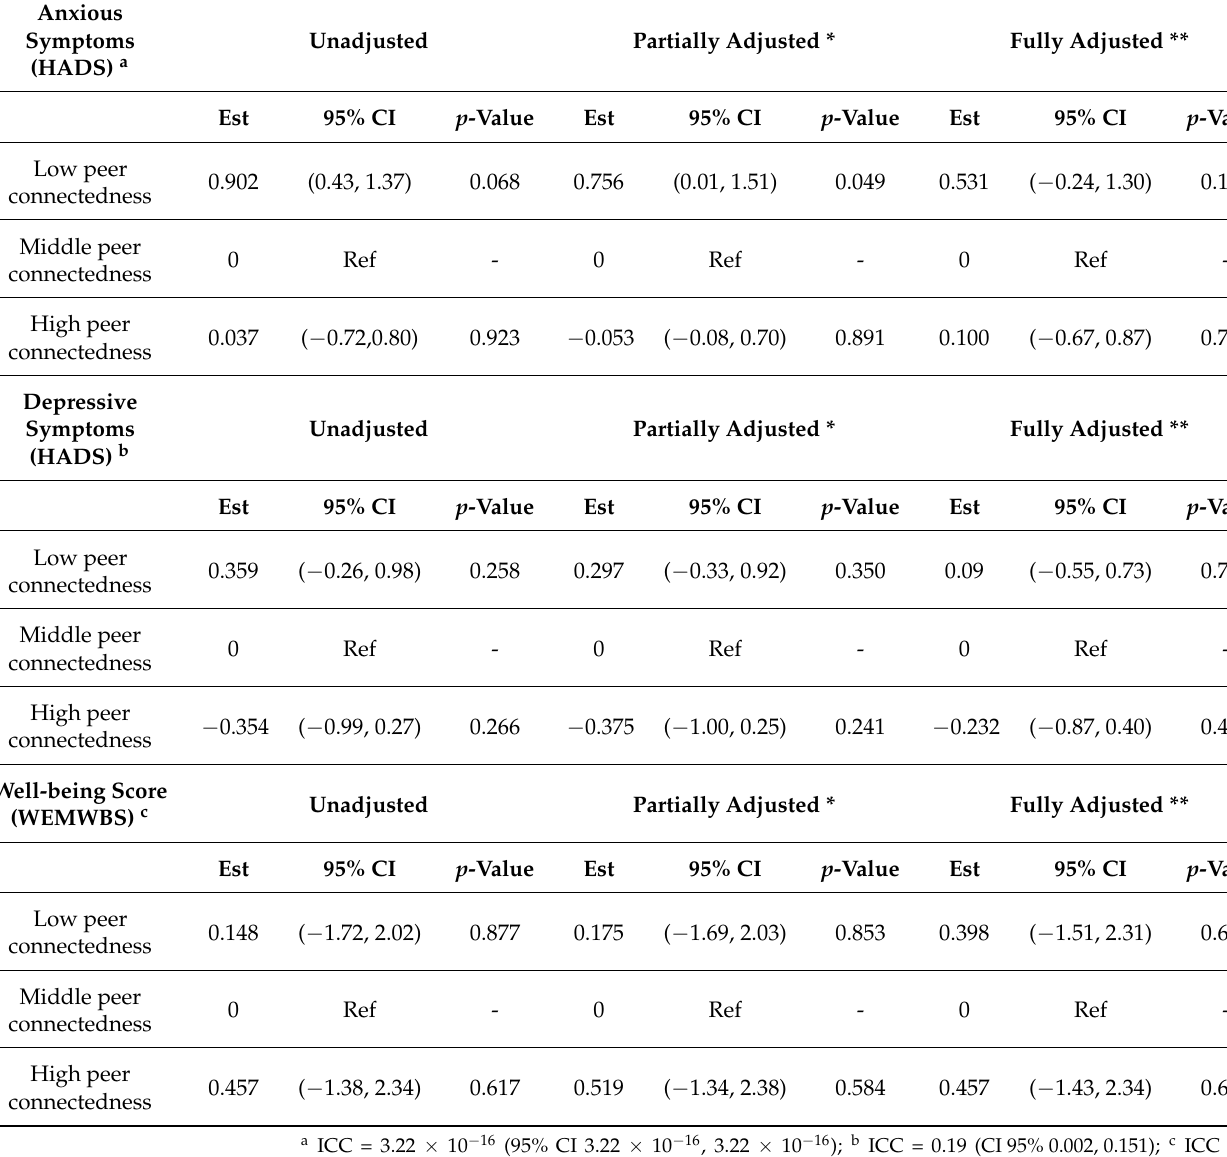
Table 4. Association of peer connectedness with change in adolescent anxious and depressive symptoms and well-being scores between lockdown and return to